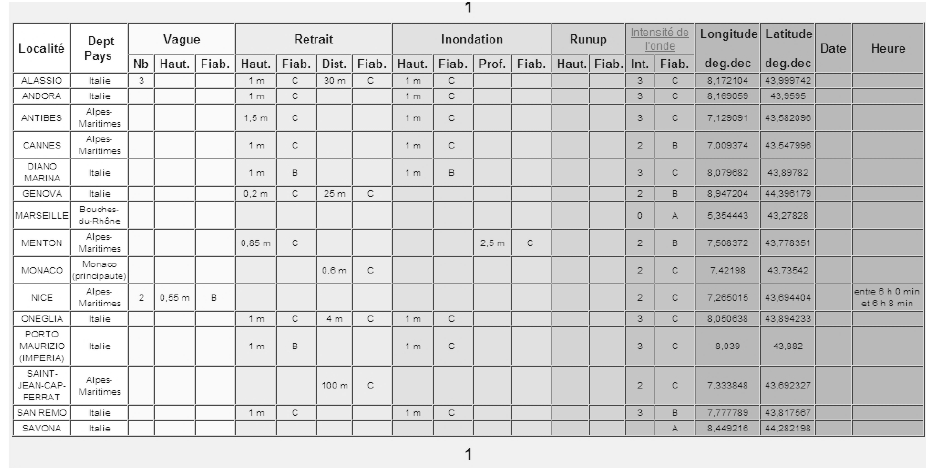
Fig. 2 – "List of observations" window: localities and parameters of the waves of the 23 February 1887 tsunami in the Mediterranean.